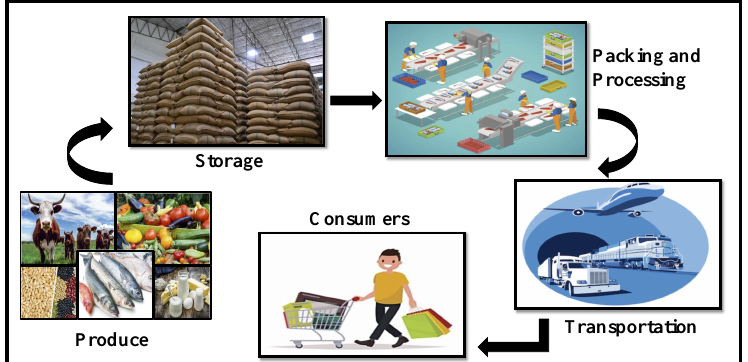
Figure 1. Stages in agricultural product distribution towards the consumers.